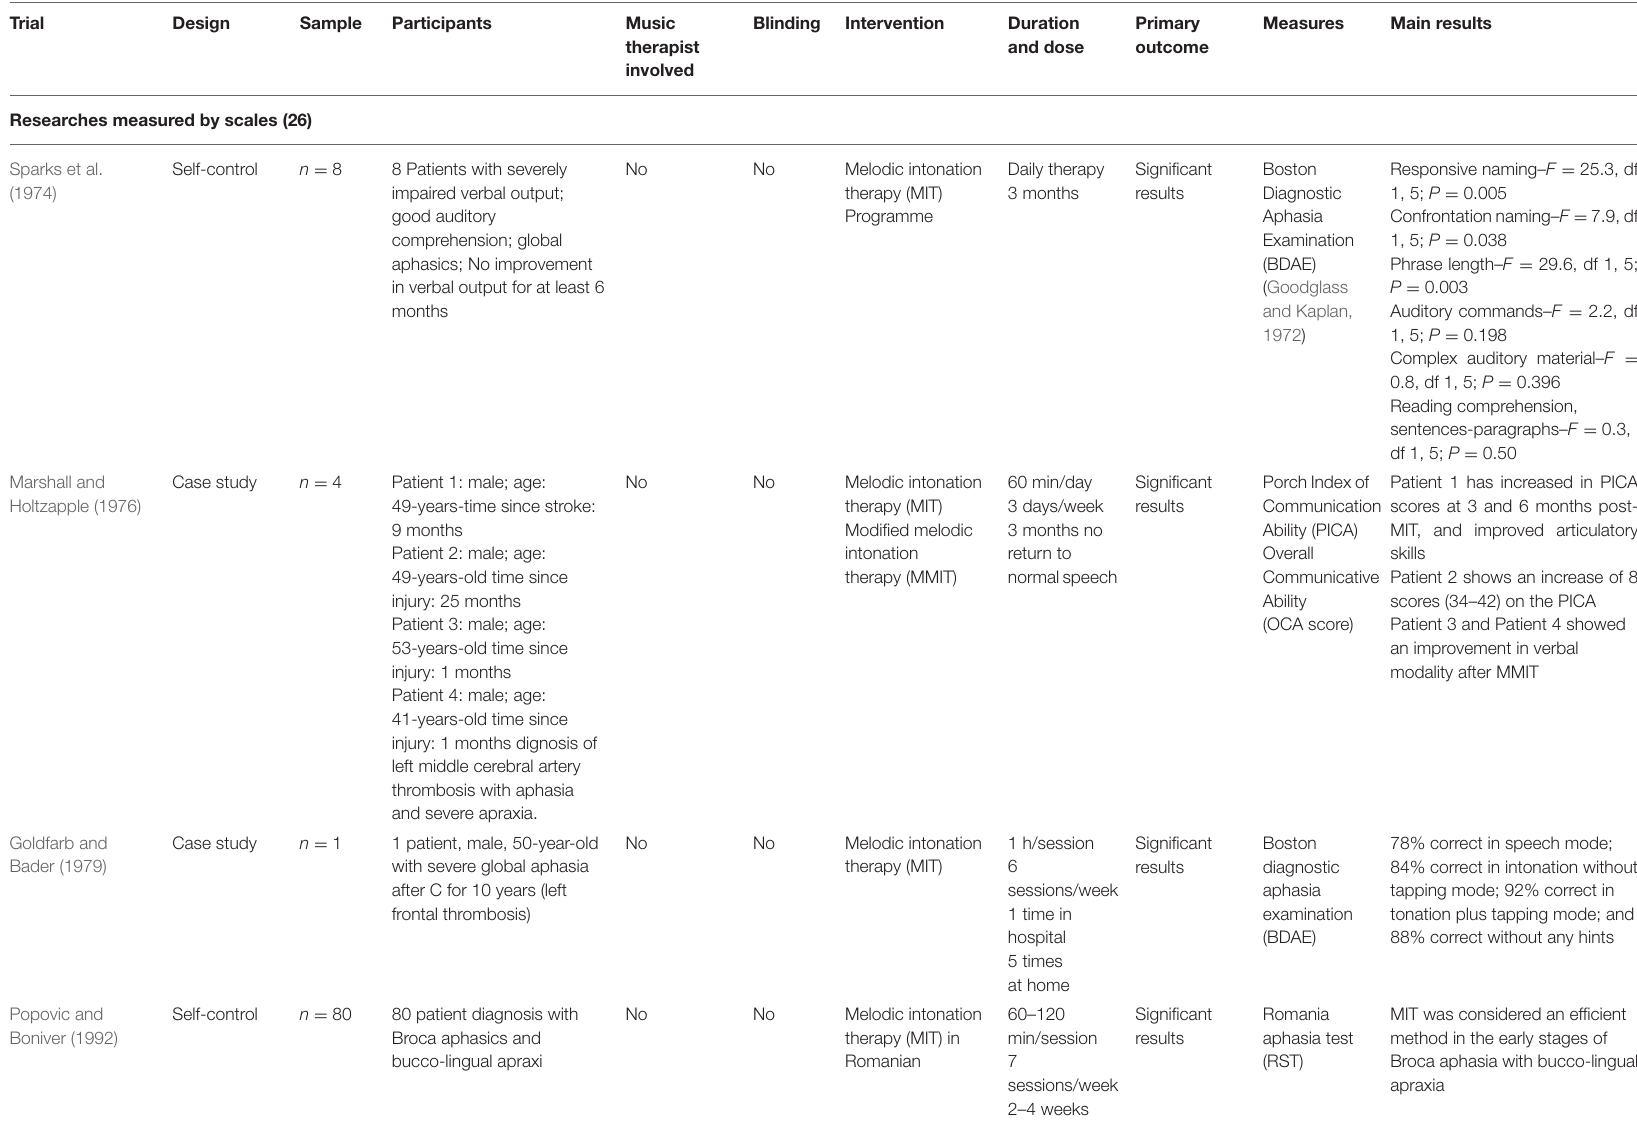
TABLE 1 | The clinical trials of MIT for the aphasia of